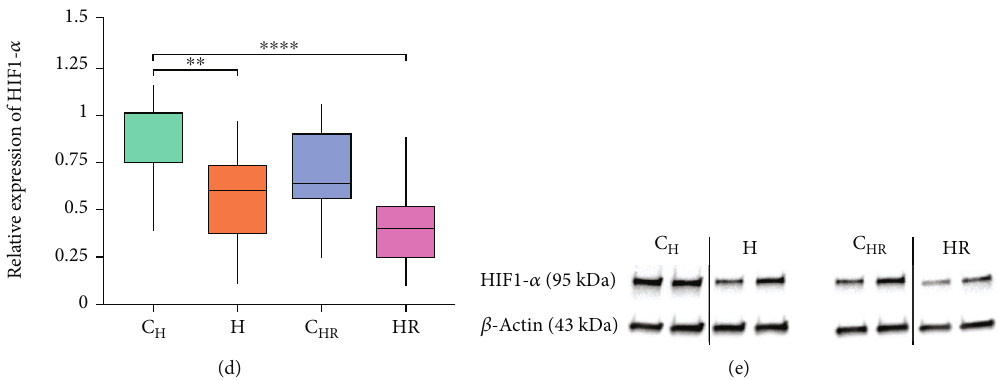
Figure 6: The e ff ect of hypoxia and reoxygenation on hiPSC-CM morphology and HIF1- α expression. (a) Di ff erences in the hiPSC-CM sarcomere structure (cMyBP-C, green) were observed after hypoxia and reoxygenation (scale bar 50 μ m), and the nucleus area was observed to decrease (counterstained with DAPI, blue). The changes in the HIF1- α (magenta) expression were not obvious via ICC. Confocal images of the cTnT staining of the control, hypoxia, and hypoxia-reoxygenation samples are presented in Supplementary Figure S3. (b) Phase-contrast image of the hiPSC-CMs seeded on MEA before and after hypoxia-reoxygenation treatment showed changes in the CM morphology after hypoxia-reoxygenation compared to before (scale bar 500 μ m). (c) Area of the hiPSC-CM nuclei was observed to decrease after hypoxia (H) and reoxygenation (HR) compared to controls (C western blot was observed to decrease after hypoxia and hypoxia-reoxygenation compared to control. The blot presents two biological replicates for each condition. (e) Example blots of β -actin and HIF1- α from western blot. Full blots are presented in Supplementary Figure S4. ∗∗ p < 0 : 01 and ∗∗∗∗ p < 0 : 0001